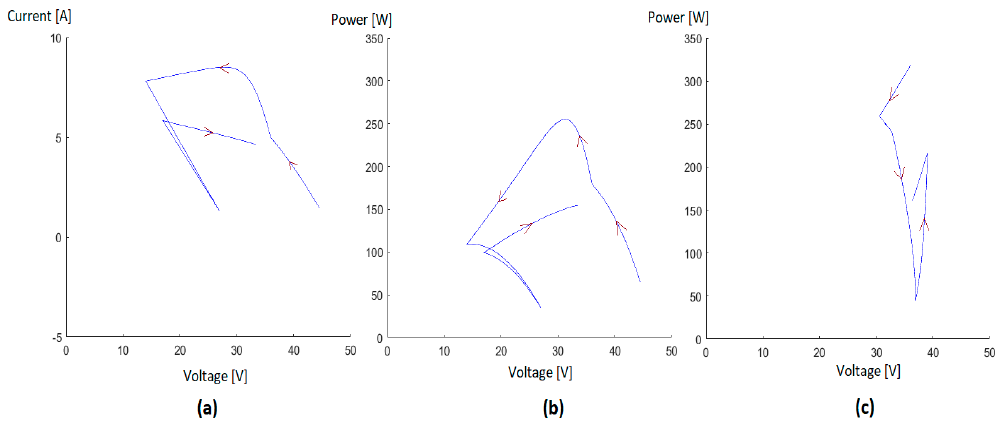
Figure 6. PV testing of the optimisation algorithm without controlling the power: ( a ) measured PV V/I curve; ( b ) measured V/P curve; and ( c ) maximum possible V/I.